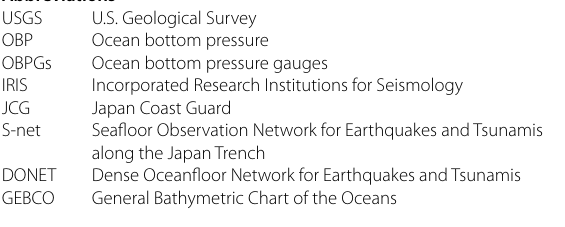
tion in the case study of Japan after the Tonga eruption. Figure S2. The change of travel time difference per unit distance Δ s (min/km) relative to water depth h. Figure S3. DONET stations and observed OBP waveforms compared to the simulated waveforms of air pressure, sea surface, and bottom pressure. (a) The circles represent the locations of DONET stations. The areas shaded by white, green, and yellow indicate the zones of Δ t ( s ) of < 6, 6–12, and > 12 min, respectively. The stations connected with dark lines are the circles filled with the color corresponding to their Δ t . The waveforms of those stations are shown in Fig. S3b, c from west to east. (b, c) The waveforms of the stations connected with dark lines from west to east in Fig. S3a. Black lines illustrate the observed bottom pressure data. Red, green, and blue lines are the input air pressure wave, simulated sea surface heights, and simulated bottom pressures. The background color of the station name corresponds to the circle’s fill color in Fig. S3a. Figure S4. The wave height distribution at the snapshot at 110 min in the synthetic test of the air pressure wave travels from deep to shallow water as shown in Fig. 2. The air pressure wave travels from left to right. The contour lines at around x 3002 km indicate the 5° updip slope, where the water = depth changes from 4 km on the left to 1 km on the right. The green line indicates the profile interval in Fig. 2a (left plot). The waves from right to left are the positive pressure‑forced wave (Wave 1 in Fig. 2), the negative ocean gravity wave, and the positive pressure‑forced wave reflected on the left